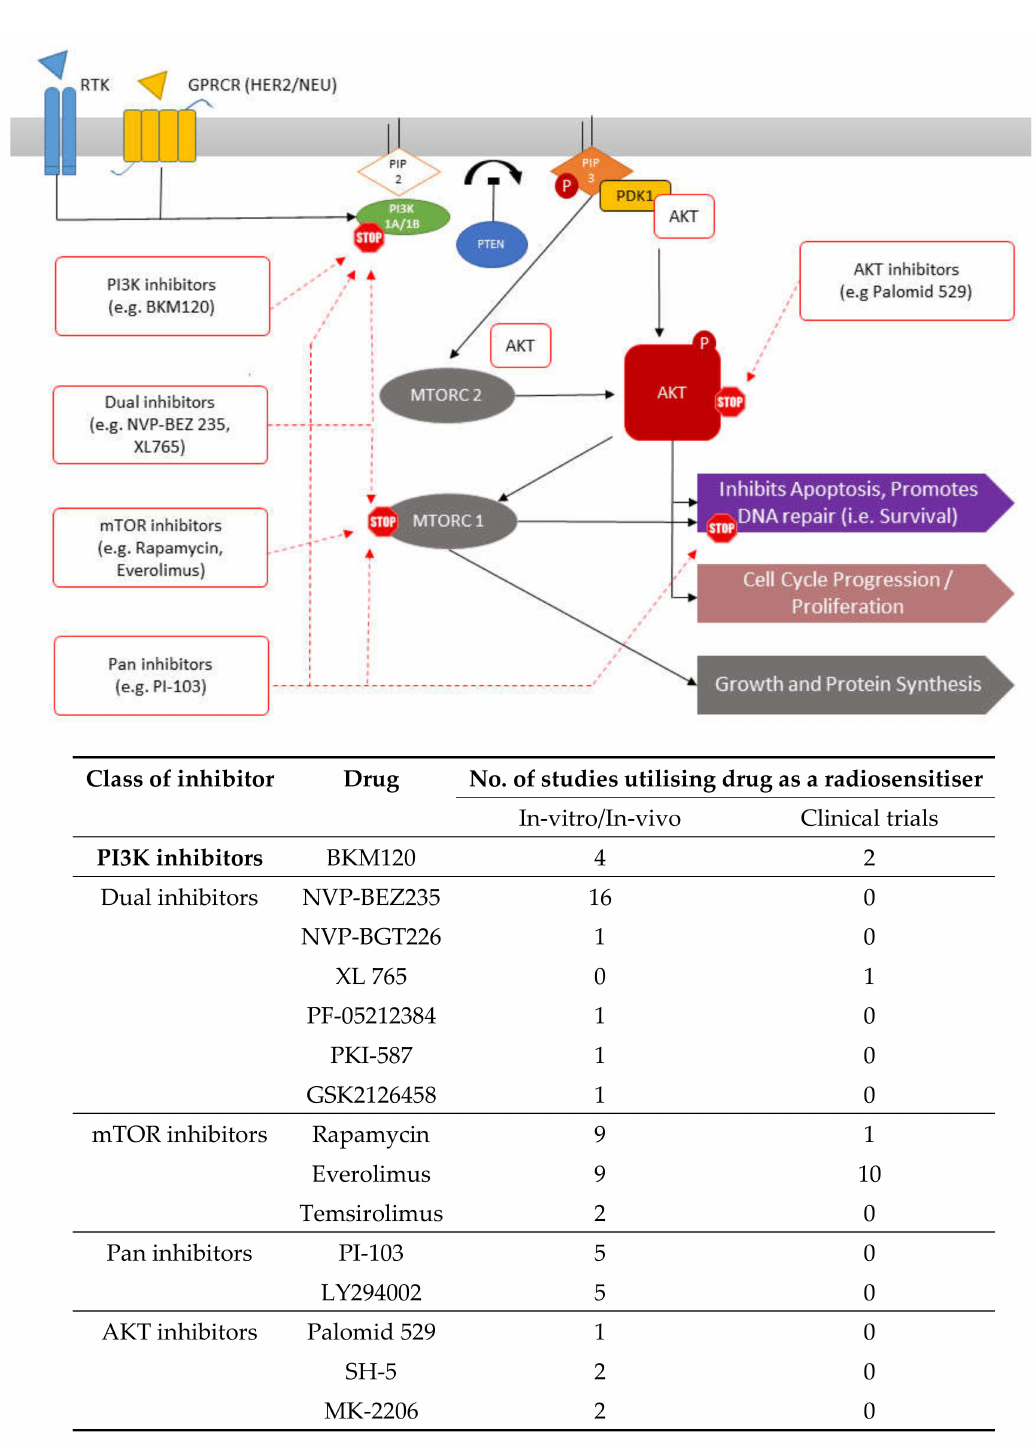
Figure 2. Targets for inhibition by various inhibitors along the PI3K / AKT / mTOR